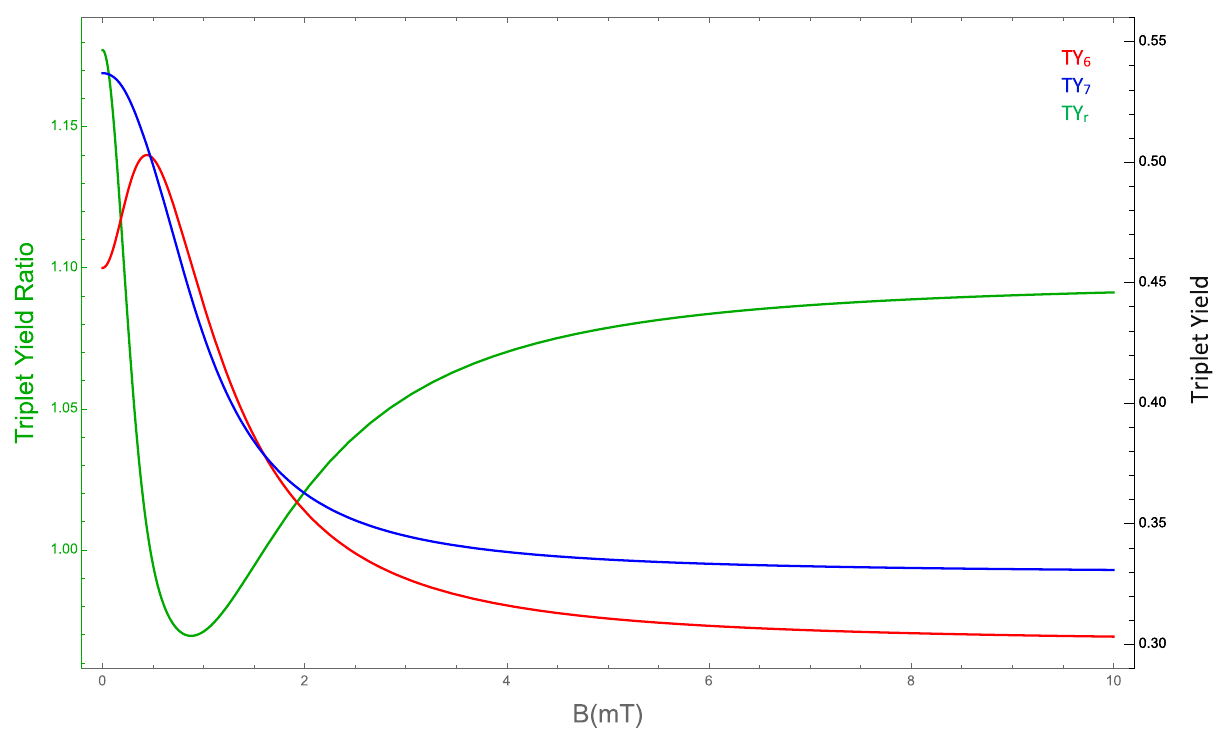
6 7 Li, TY 6 , (red) and Li, TY 7 , (blue) and the triplet yield